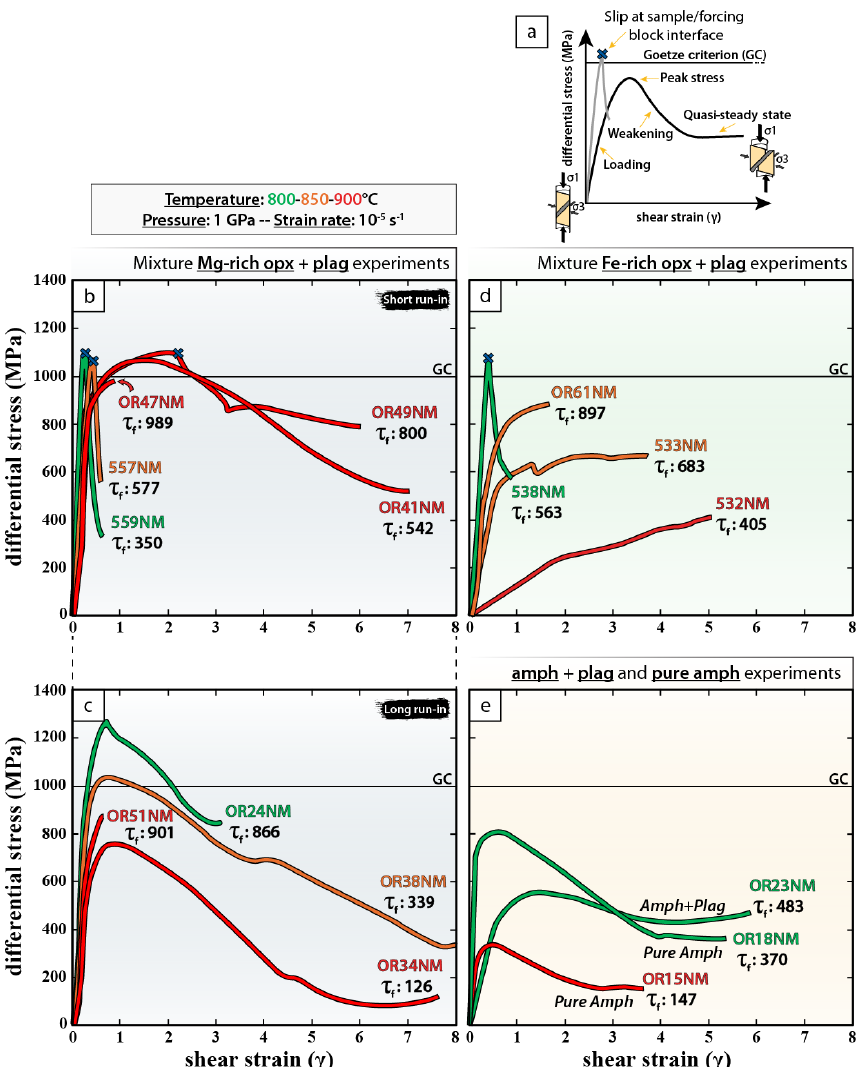
Figure 2. Mechanical data. (a) Terms used to describe the different stages of an experiment. (b–c) Differential stress (MPa) versus shear strain ( γ ) showing the mechanical behavior of the Mg-rich opx + plag assemblages deformed at temperatures ranging from 800 to 900 ◦ C, at constant confining pressure of 1GPa, and at a strain rate of 10 − 5 s − 1 . The difference between (b) and (c) is related to the different duration of the “run-in” section, i.e., time spent at P – T conditions before the hit point. Mechanical data for Fe-rich opx + plag (d) as well as amph + plag and pure amph (e) assemblages are also plotted in stress–strain graphs. opx: orthopyroxene, pl: plagioclase, amph: